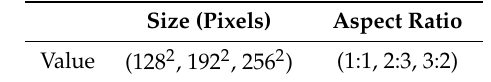
Table 1. Parameter Table 1. Parameter values. Table 1. Parameter values.